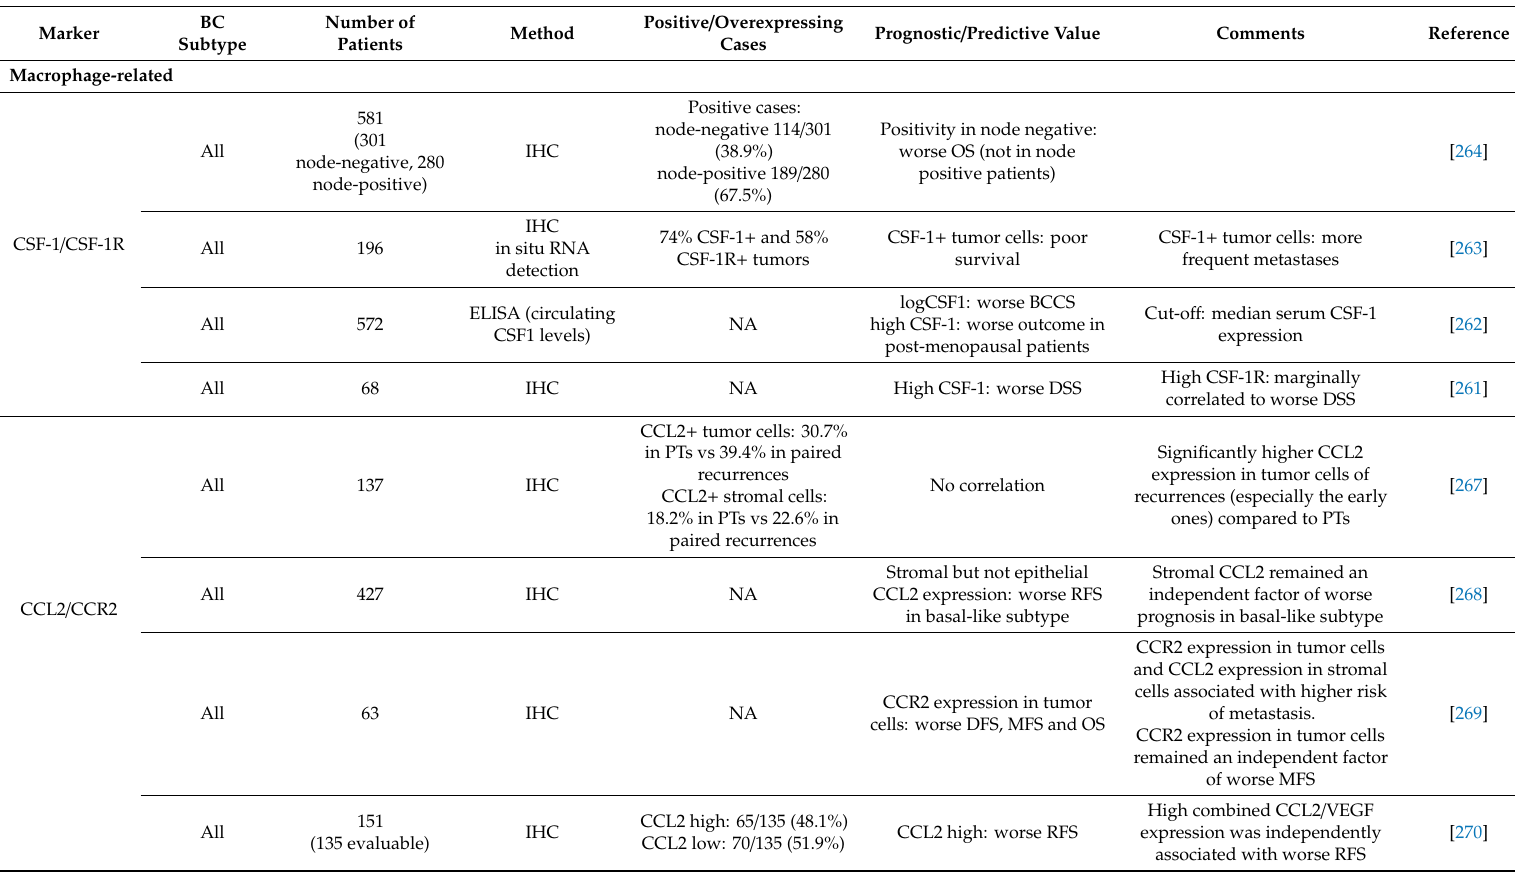
Table 3. Expression and prognostic / predictive value of immune-related markers predominantly expressed by macrophages, NK and dendritic-cells in breast cancer (BC)